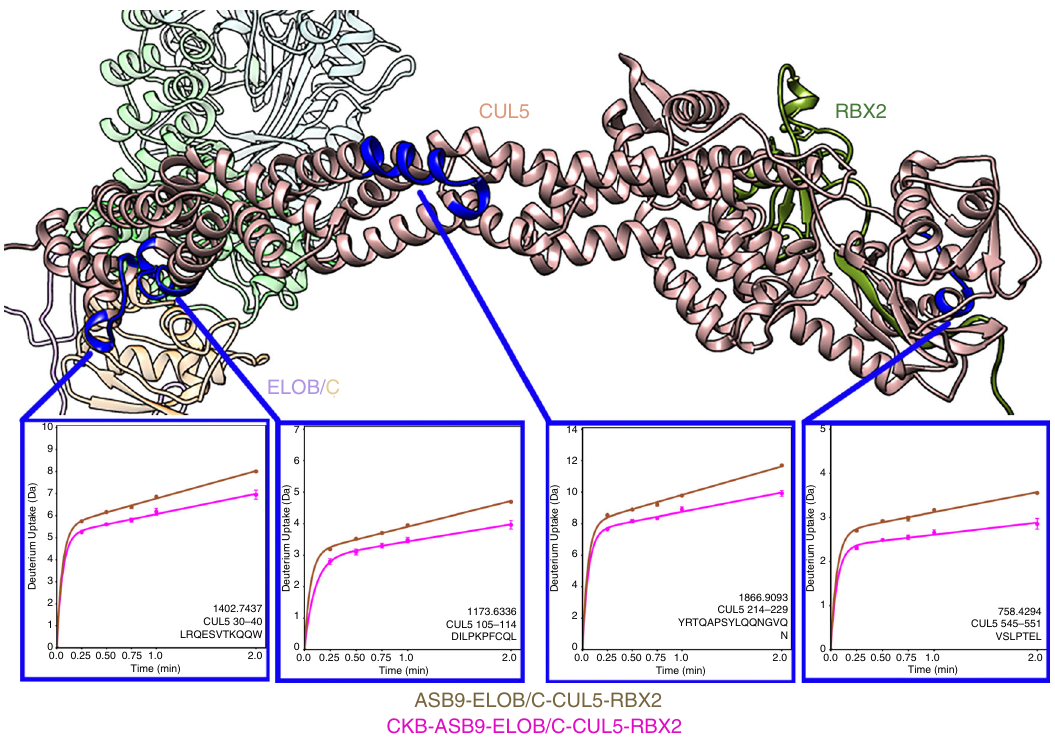
Fig. 6 CKB binding induces changes in HDX in CUL5. CUL5 (brown circles) residues 30 – 40, 105 – 114, 214 – 229, and 545 – 551 showed decreased exchange upon CKB binding (magenta circles) to the ASB9 CRL. For all HDX-MS data, at least two biological replicates were analyzed each with three technical replicates. Data are represented as mean values ± SEM of three technical replicates due to processing software limitations, however the LEAP robot provides highly reproducible data for biological replicates and therefore error bars are sometimes within the symbols. Source data for the HDX-MS results are provided as Source Data fi